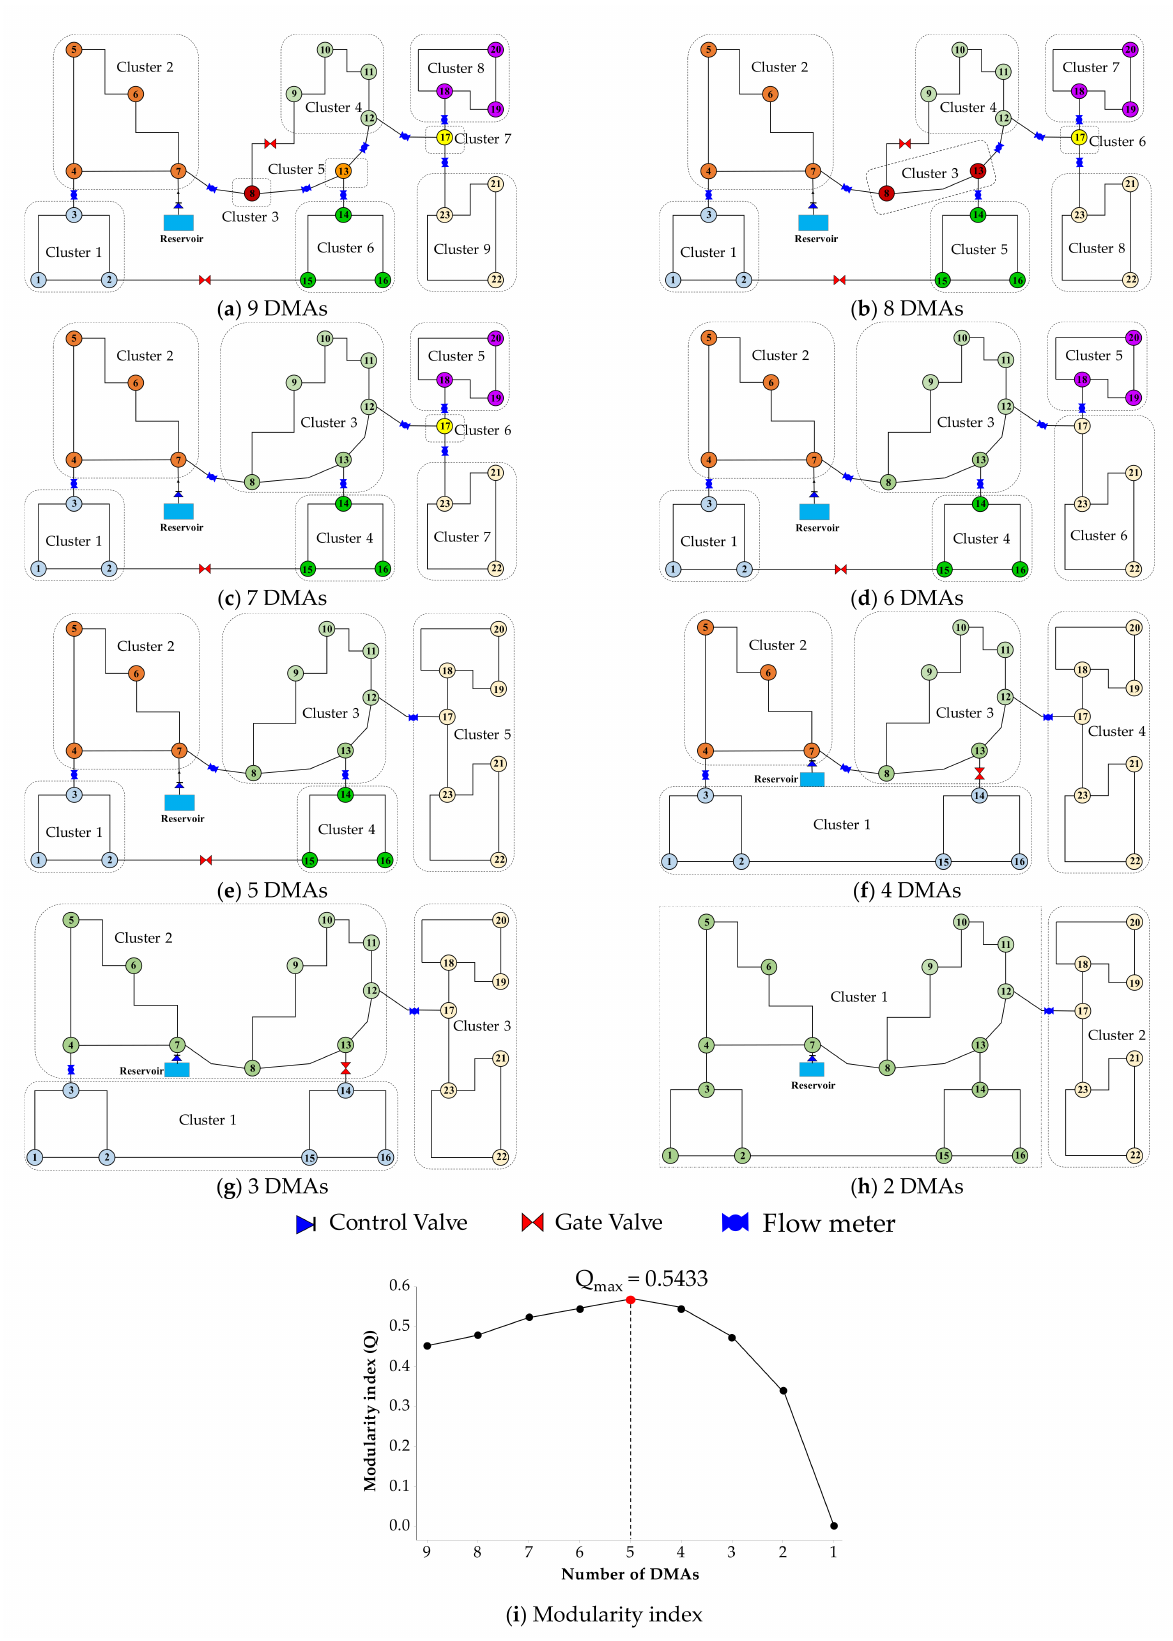
Figure 7. Post-partition results of the CSA: ( a – h ) multiscale DMA layouts (from 9 to 2 DMAs); ( i ) variation in modularity index with the number of